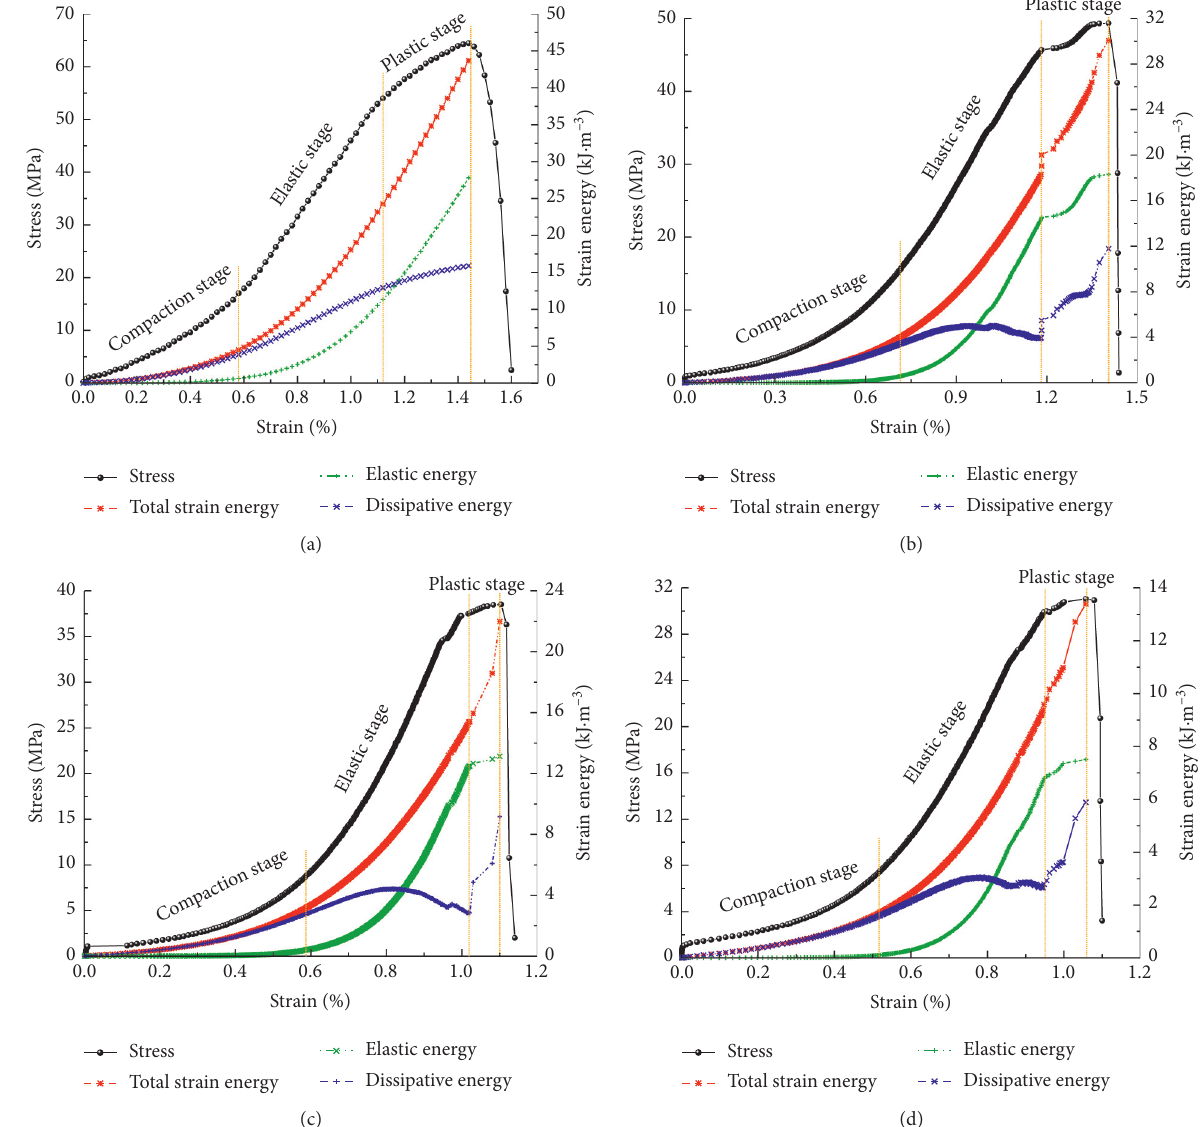
Figure 5: The relationships between stress, prepeak strain energy, and strain in typical intact (a) and precracked rock specimens with crack angles of 30 ° (b), 45 ° (c), and 60 °